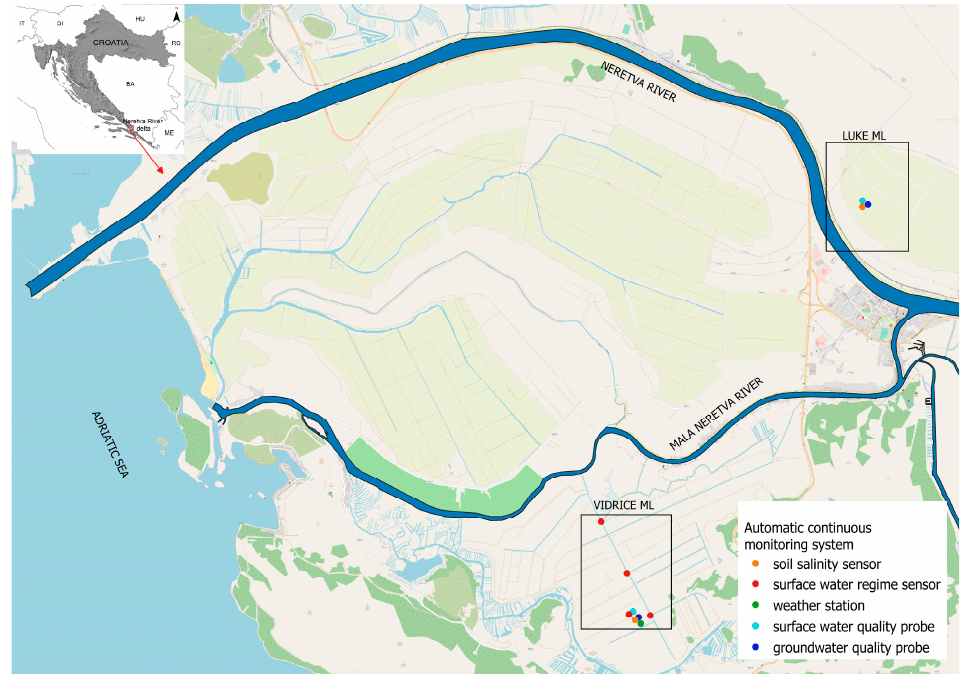
Figure 2. Project area and installed sensors (modified map form DELTASAL web portal).